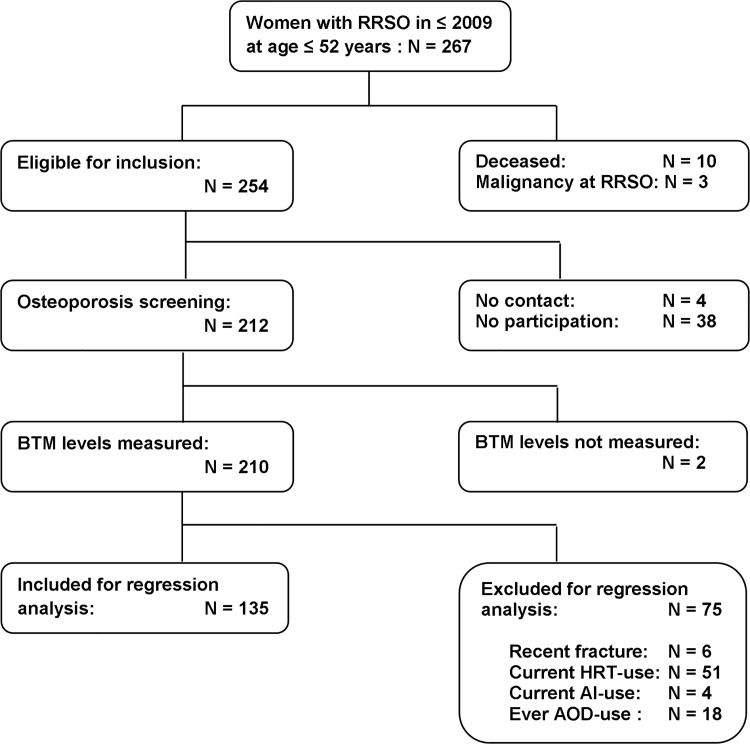
Flowchart of the inclusion process.BTMs were not measured in two women because of logistic reasons.